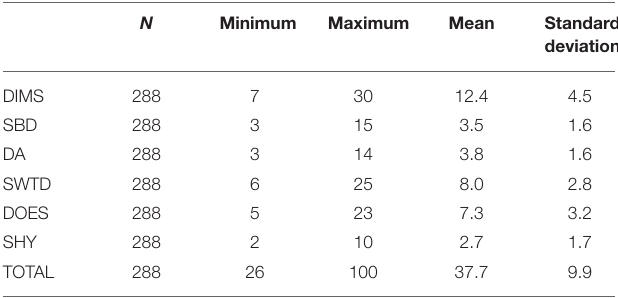
TABLE 8 | Sleep disturbance scores for all